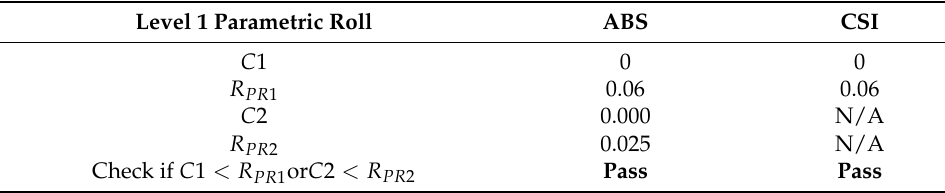
Table 12. Level 2 assessment of parametric roll failure mode for barge.